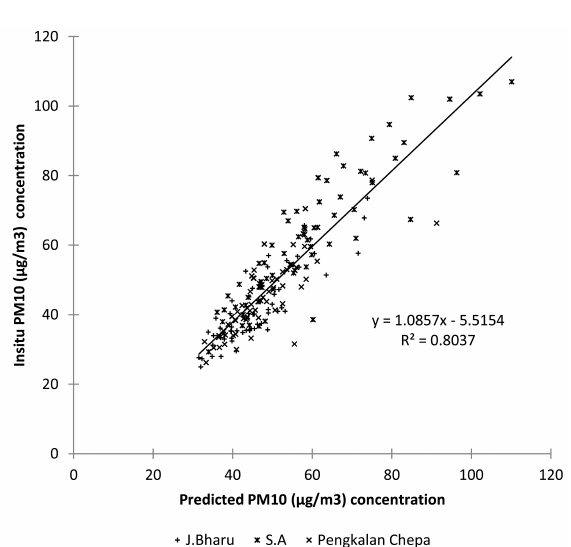
Fig. 3. Assessment of the monthly in situ PM 10 measurement and monthly predicted PM 10 by a mixed effects model. Fig. 4. Assessment of the monthly in situ PM